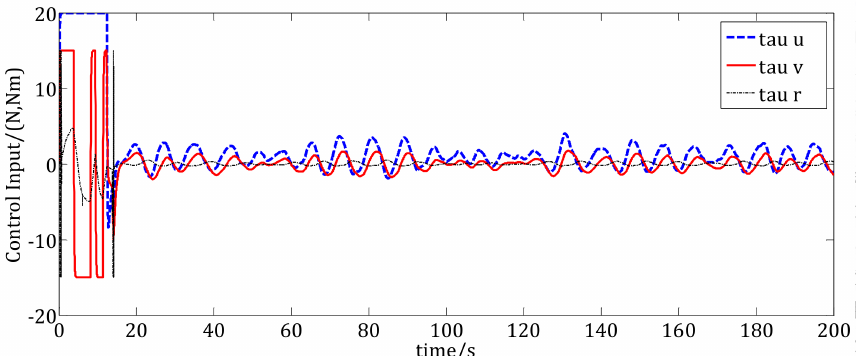
Figure 18. Control inputs of the USV under the NTTC.